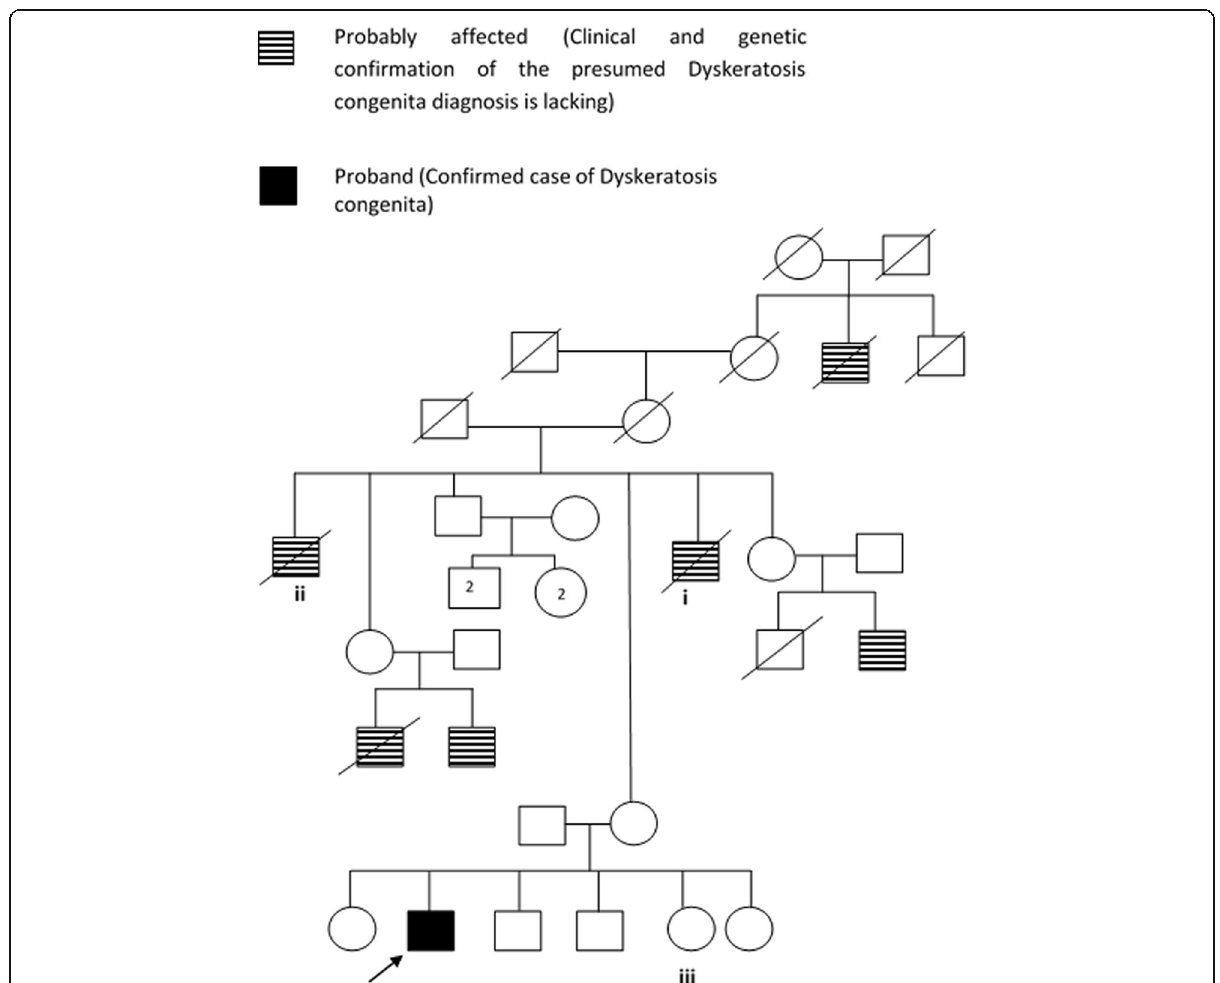
Fig. 2 Pedigree constructed from the details provided by the proband ’ s mother: i) proband ’ s maternal uncle died due to a febrile illness at the age of 26 years, ii) proband ’ s maternal uncle died at the age of 50 years due to tuberculosis, iii) proband ’ s sister is a probable carrier with history of similar localised skin pigmentation and nail changes but no history of significant illnesses or recurrent